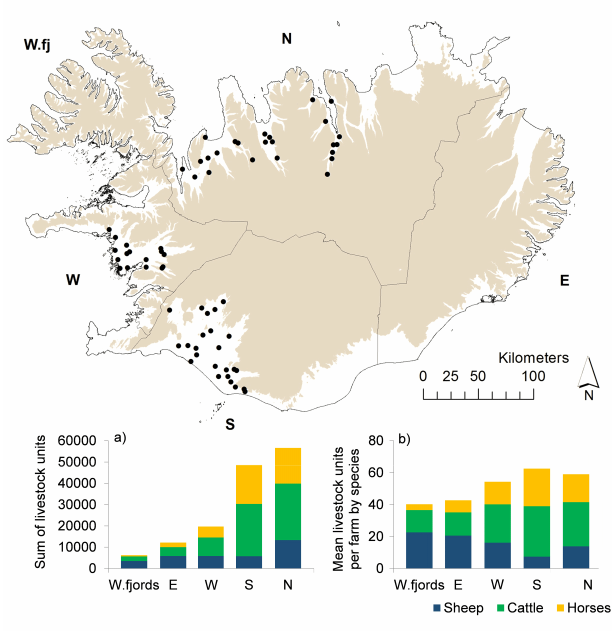
Fig. 1 . Map of Iceland (top) showing areas below 400 meters above sea level in white and the surveyed farms (filled circles) in each of the regions (indicated by lines), and the regional variation in (a) total livestock units (LU: cattle = 0.9; horses = 0.8; sheep = 0.1) and (b) composition of livestock units per farm (Statistics Iceland 2015 b